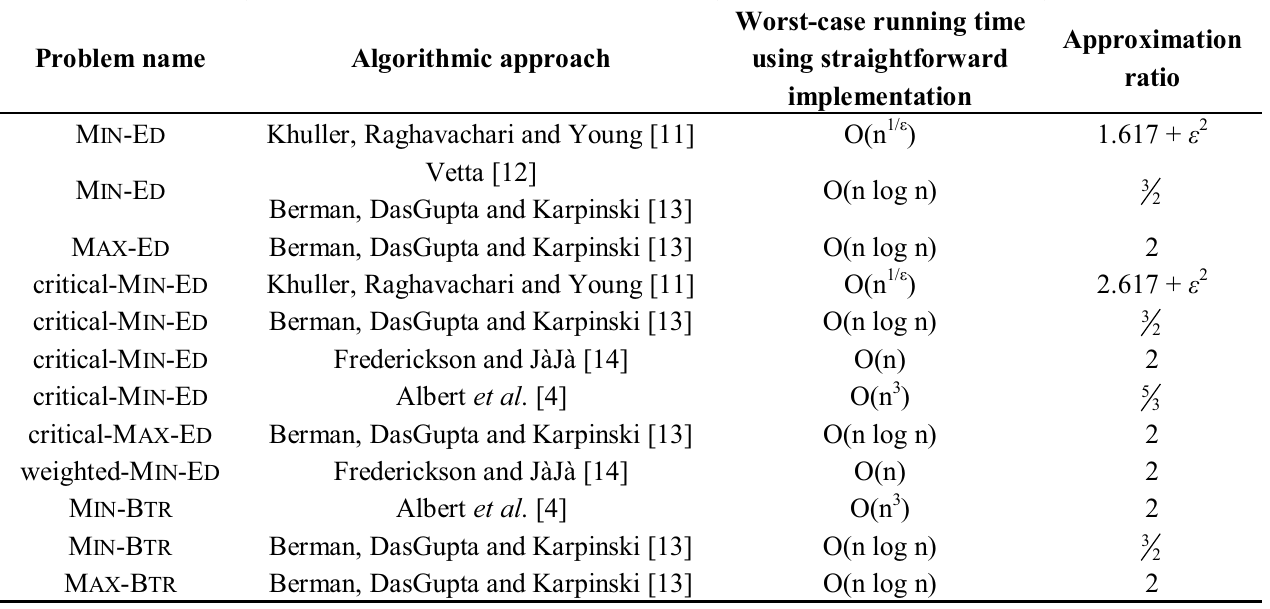
Table 1. Theoretical comparison of worst-case performance of some of the algorithms for the transitive reduction